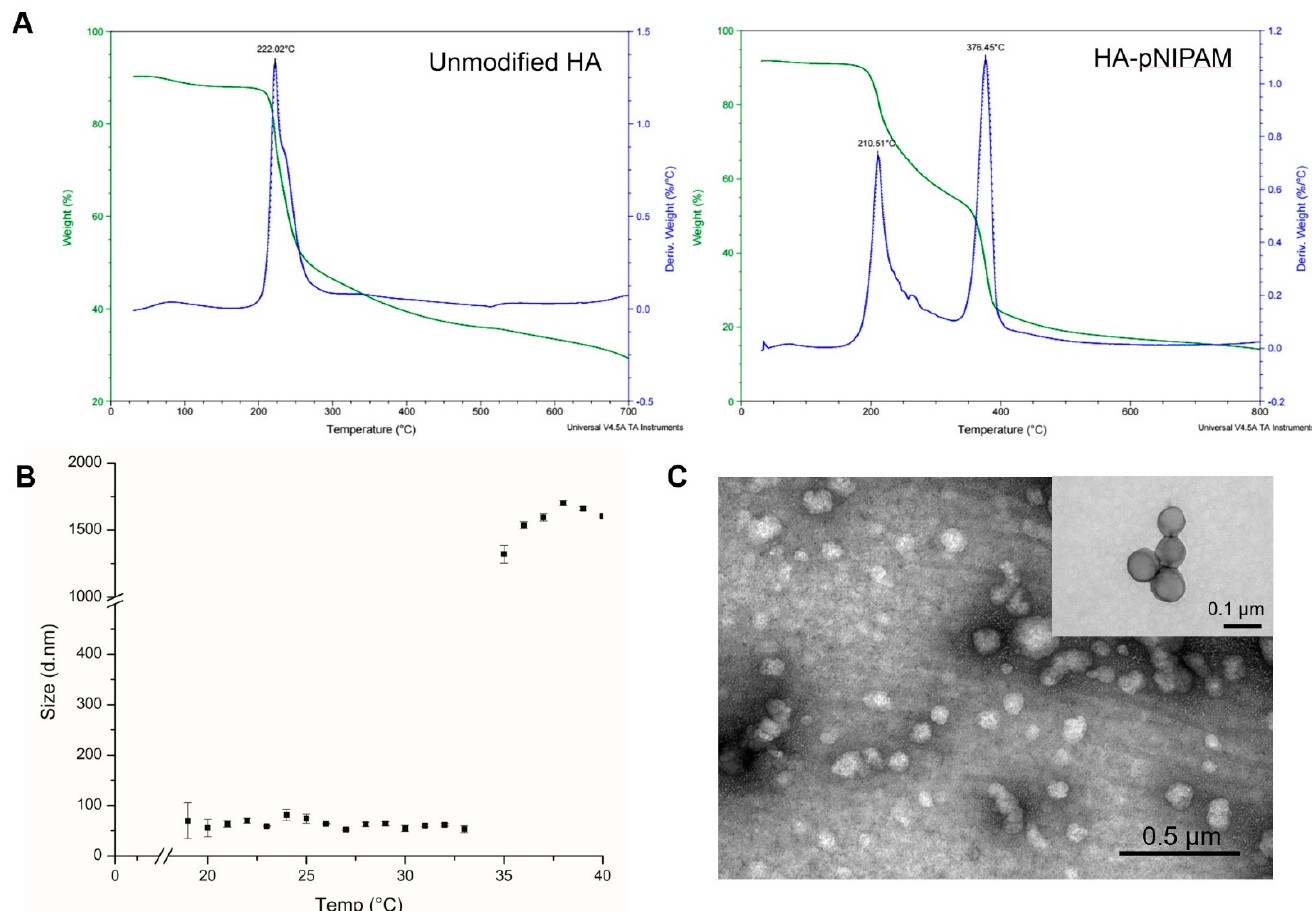
Figure 2. The characterization of HA-pNIPAM nanogel. ( A ) the thermal degradation profile of pNIPAM-grafted HA, in which the green line shows the total weight reduction; the blue line shows the derived weight reduction profile representing the grafted-polymer that decomposed at two different temperatures. ( B ) Particle size measured by DLS shows the thermoresponsive behavior of the HA-pNIPAM 05 nanogel. ( C ) The corresponding TEM micrograph represents the spherical morphology of the nanogel at 25 °C (negatively stained) with an inset image from the higher magnification TEM (positively stained). The average size of the particle strikingly changed at the LCST.